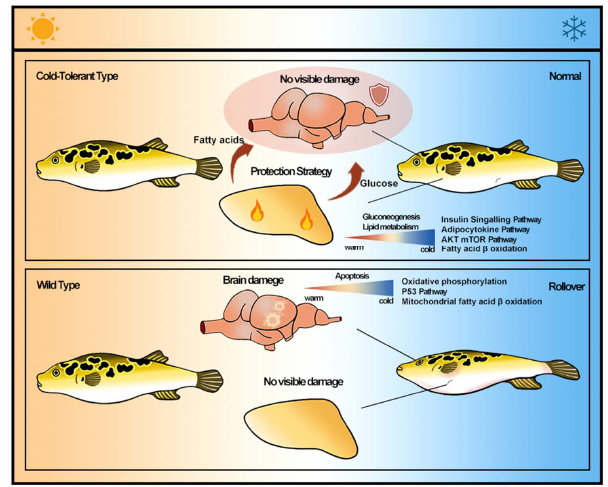
Figure 5. A schematic model illustrating genetic pathways that promotes cold tolerance at low temperatures in fugu. When the temperature dropped to 12 °C, wild-type fugu would become comatose and eventually die. In the fugu’s brain, the most important regulator and effector of motor activity, significant enrichment in p53 and apoptosis pathways could be easily detected. Physiological changes at temperatures from 7 to 4 °C indicate that cold stress would increase brain damage. In contrast, domesticated cold-tolerant fugu still had the ability to swim normally at 7 °C. Tran- scriptomic studies have revealed an increase in hepatic genes involved in glycogenolysis and lipid metabolism. We also observed increased levels of oxidative phosphorylation, and a greater supply of energy from the liver would maintain the survival of cold-tolerant fugu in cold stress.